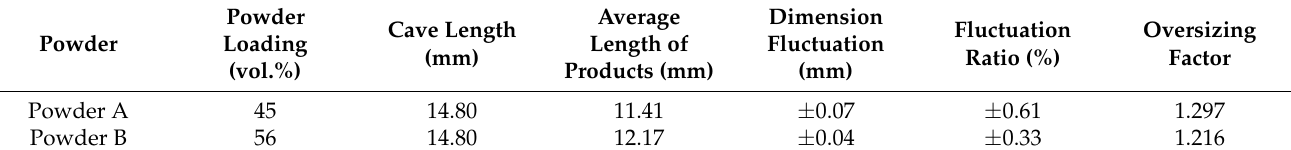
Table 3. Effect of powder loading on dimension precision and oversizing factor (OSF) of the supporter parts.